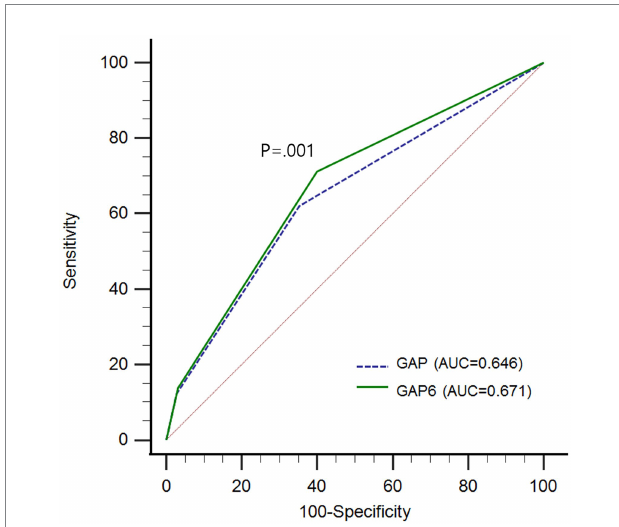
FIGURE 4 Comparison of predictive performance between GAP model and GAP6 with area under curves (AUCs) using receiver operating characteristic (ROC) curve analysis GAP, gender, age, and physiology; GAP6, gender, age, and physiology with desaturation during six-minute walk test; AUC, area under curve; ROC, receiver operating